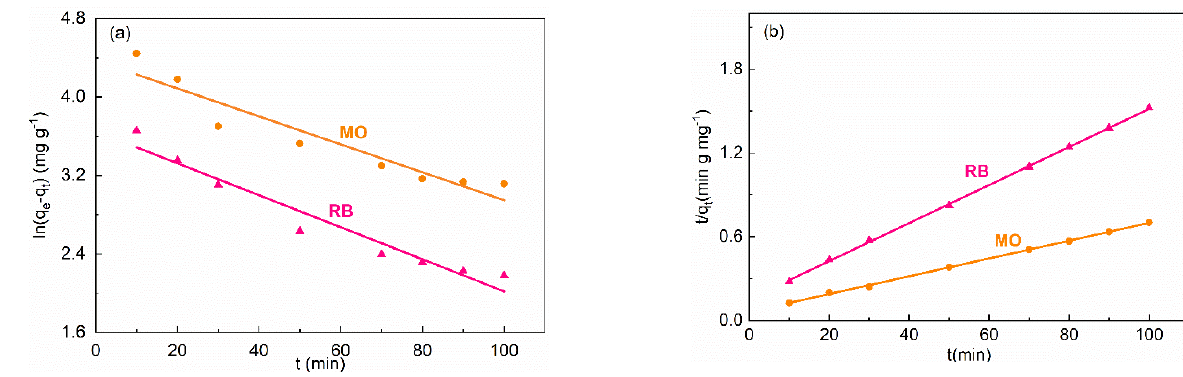
Figure 5. ( a ) Pseudo-first-order and ( b ) pseudo-second-order of the kinetics data.